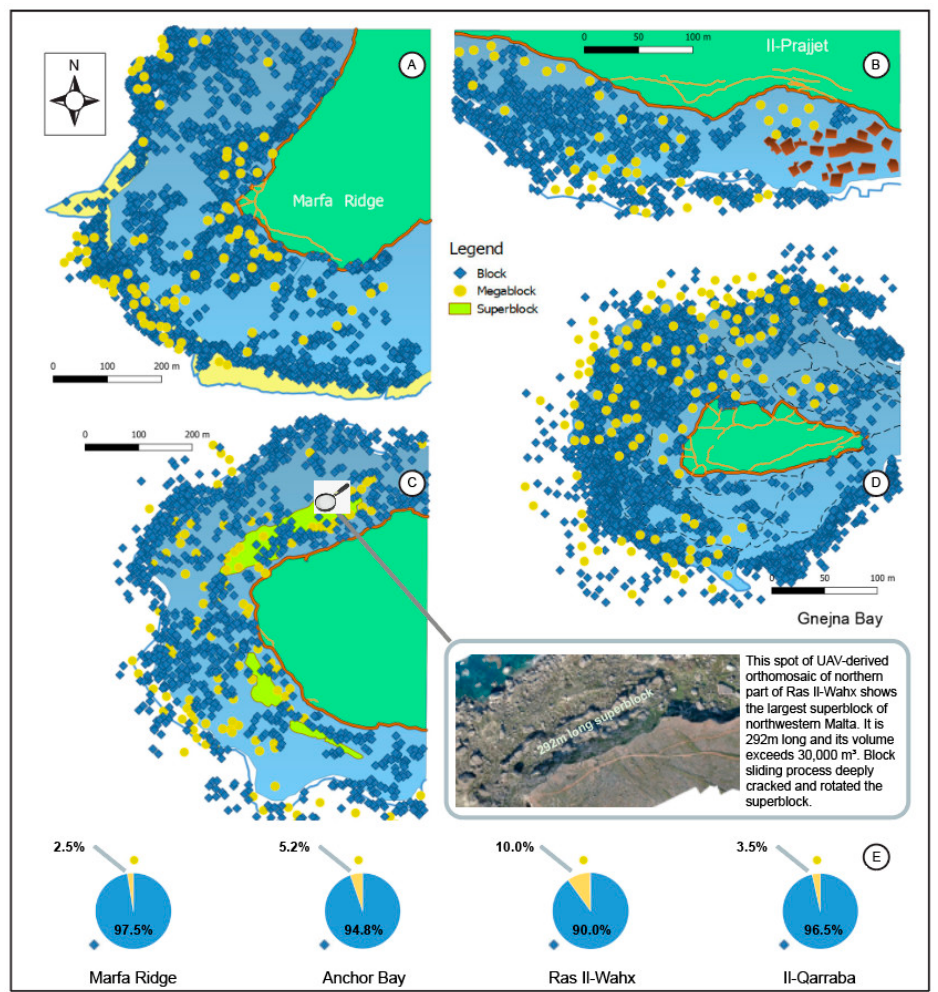
Figure 13. Megaclast inventory maps of ( A ) Marfa Ridge; ( B ) Anchor Bay; ( C ) Ras Il-Wahx headland; ( D ) Il-Qarraba peninsula; ( E ) percentages of each classes with respect to the total population. Table 8. Megaclast size analysis within the study sites using drone DP outputs. Location Block Location Megablock